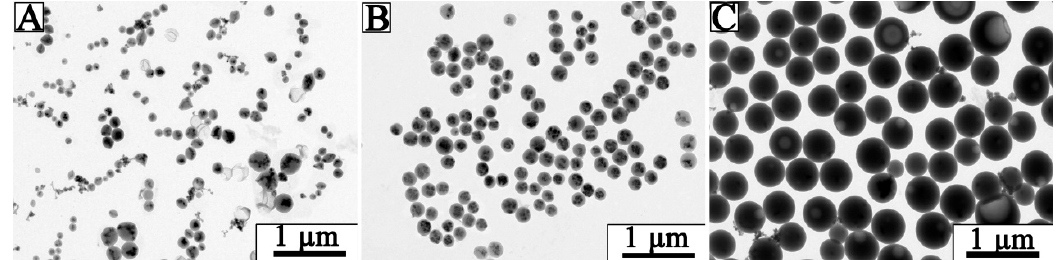
Figure 3. TEM images of Fe 3 O 4 @LNPs prepared by ( A ) L 1 : 0.5 mg/mL, ( B ) L 2 : 1.0 mg/mL, and ( C ) L 3 : 5.0 mg/mL lignin.